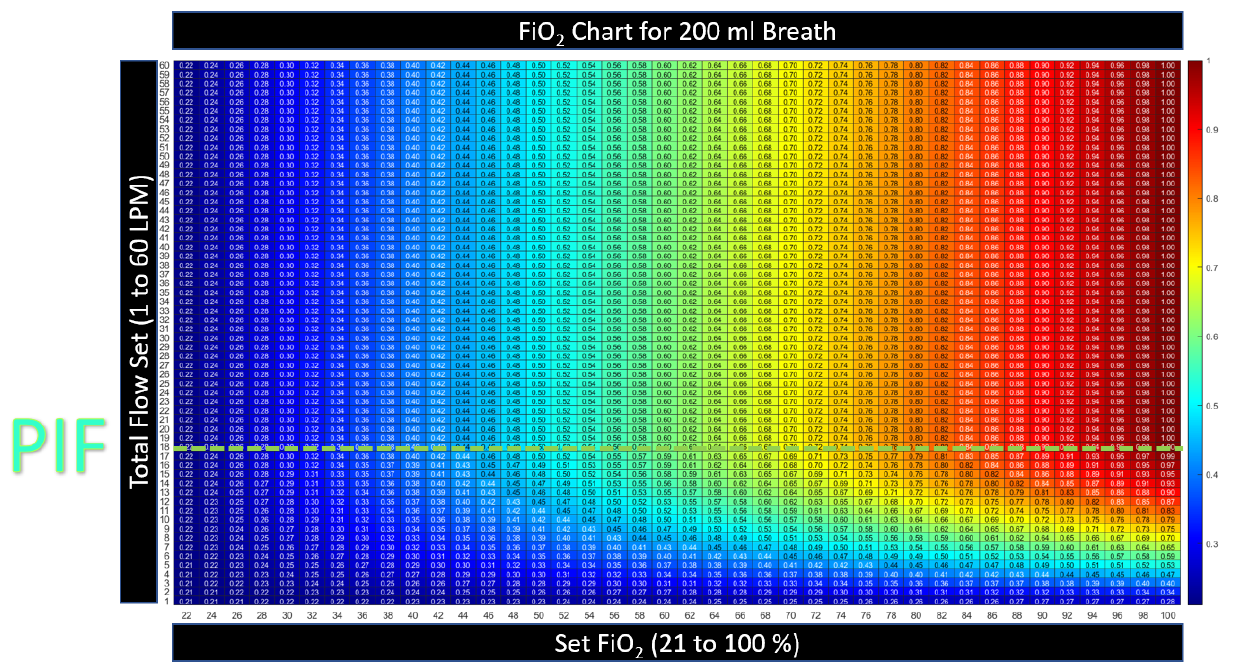
Figure 4. The relationship between the settings and the tracheal F i O 2 for HFNT on a shallow breath: 200 mL, PIF = 18 LPM. When the flow setting is above the peak inspiratory flow (PIF), the tracheal F i O 2 is equal to the device F i O 2 , and no change in FiO 2 is expected in any column above the PIF. The numbers contained within the table are kept small; see the color convention to represent the number, described in Section 2.3.2.